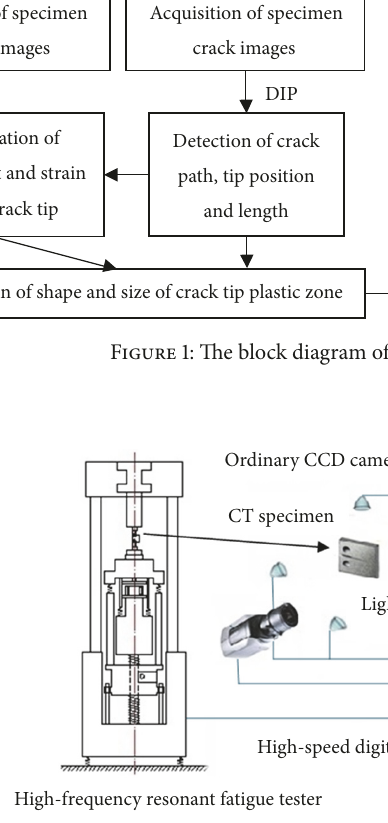
pixel size of 9 𝜇 m × 9 𝜇 m, and frame rate of 135fps. The lens is the macro lens with megapixel which matches the camera and the maximum magnification is 1.0. The calibration value of this crack length measuring system is 0.00949 mm/pixel